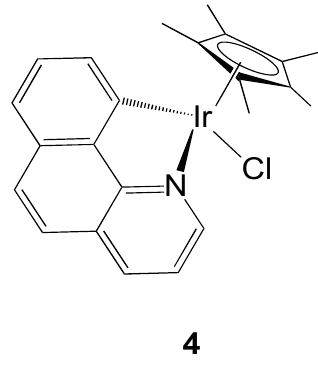
Figure 7. Schematic drawing of the organometallic compound [( ƞ 5